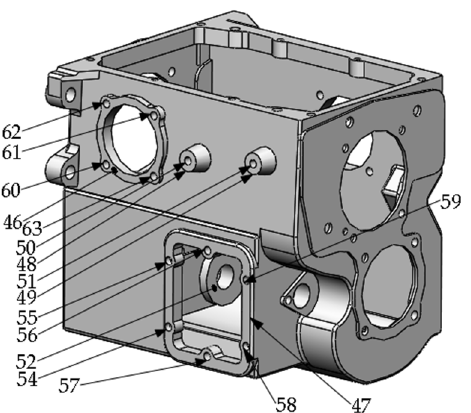
Figure A4. Machining tasks on Left surface.